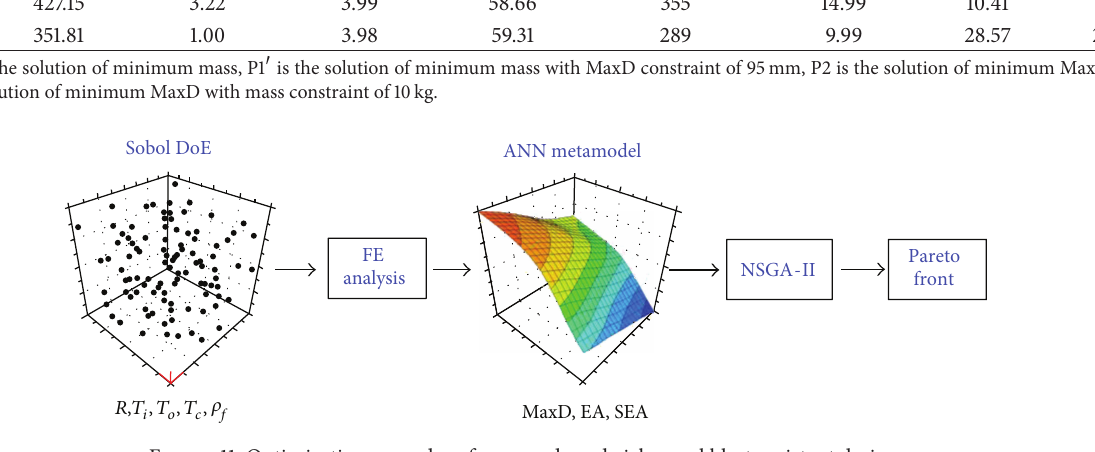
panels, respectively. This indicates that thickening the outer face is the most effective way to reduce inner face deflection with the minimum mass increment of the curved panel. This is also confirmed by the correlation matrix in Figure 12, which shows that 𝑇 𝑜 ranks the third highest in affecting MaxD but among the lowest in affecting the mass, of the five variables. For the same reason, the upper bound of 𝑇 𝑜 is reached for Panels P2 and P3, which provides the minimum MaxD under different mass constraints. Similarly, the foam core thickness 𝑇 𝑐 also attains near upper bound values for Panels P2 and P3. By comparison, the competing effects in deflection